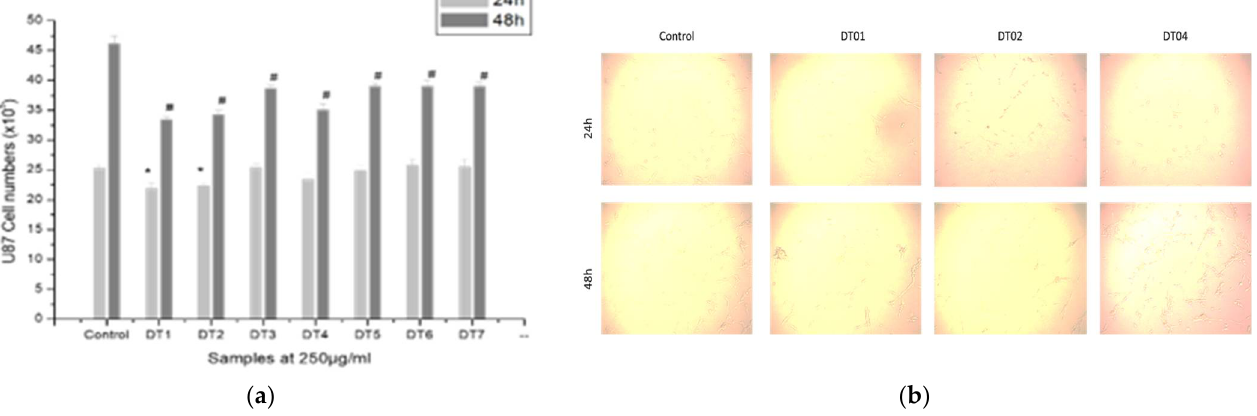
Figure 6. ( a ) Graphical presentation represents the u87 MG cell number after treatment with tea plants extracts (DT01–DT07) at 250 µg/mL for 24 h and 48 h. Values are expressed as mean ± SEM, n = 3. * Significant difference ( p < 0.05) compared to 24 h control group. # Significant difference ( p < 0.05) compared to 48 h control group. ( b ) Light microscopic images of cell proliferation of Control, DT01, DT02, and DT04-treated groups at different times.